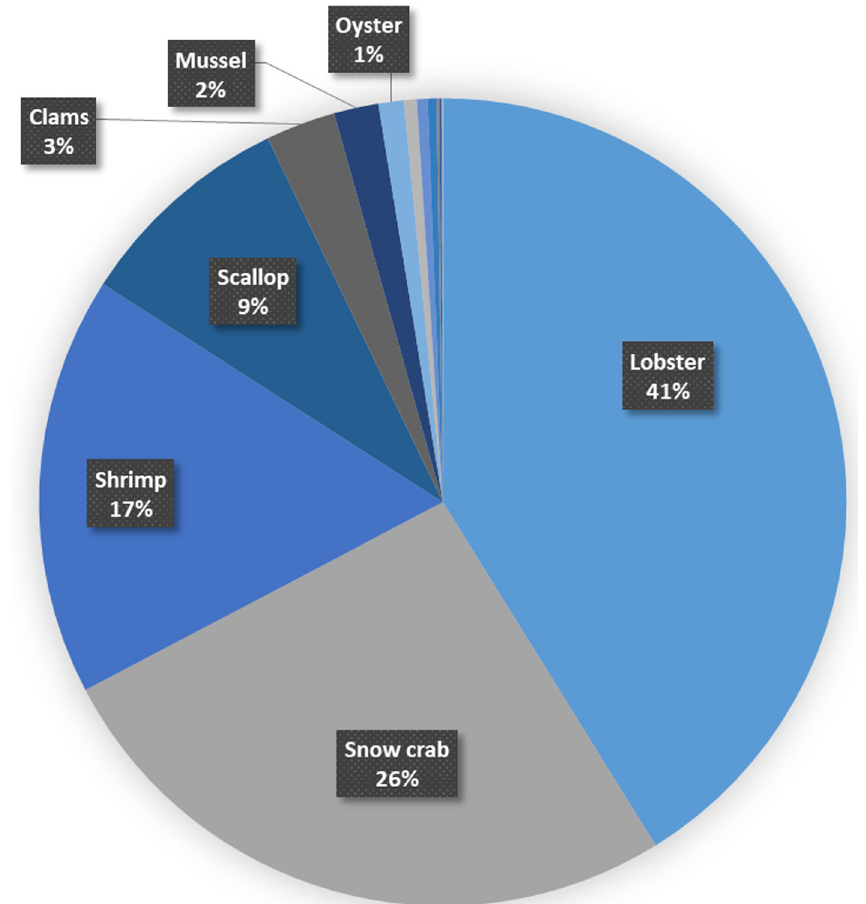
crab species (i.e., not snow crab), sea urchin, whelks and sea cucumber as well as ‘other shellfish,’ which together amount to 1.5% of the total value. Note that ‘clams’ refers to several species, however Stimpsons’ Surf Clam is by far